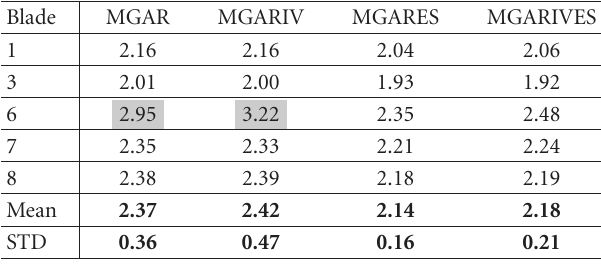
Table 3: 2EO case: blade-by-blade engine order estimates.